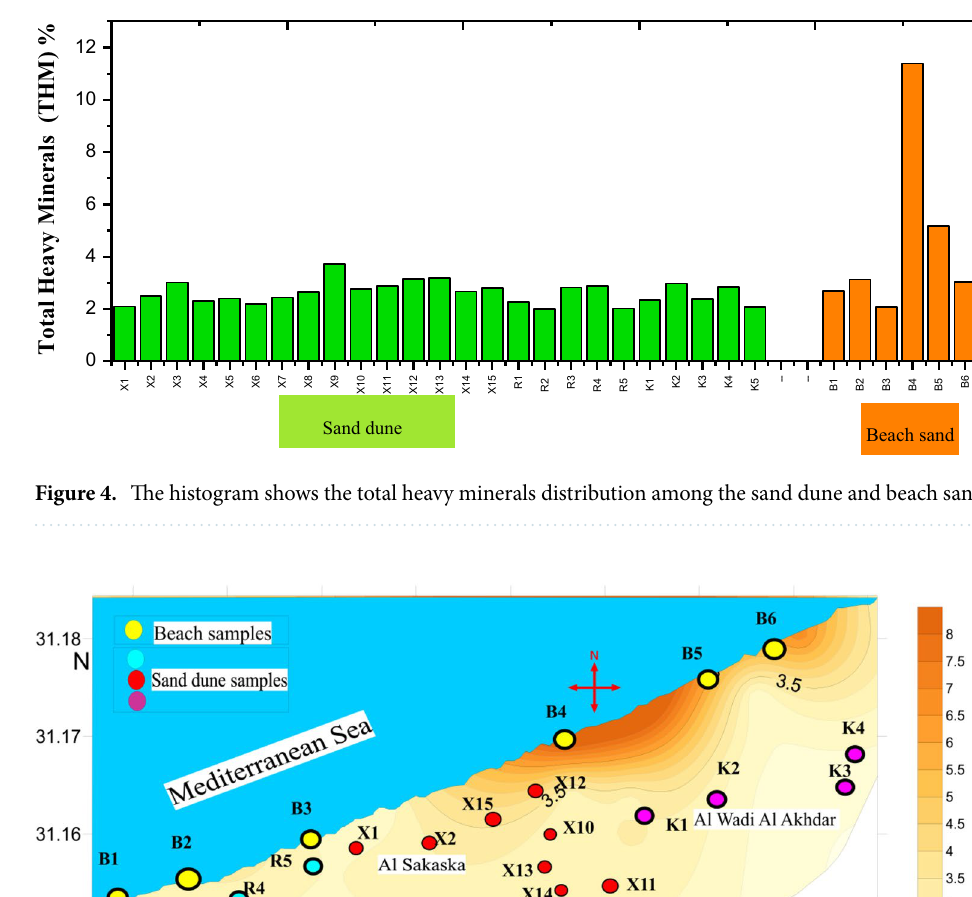
clear color with a vitreous luster 37,38 . Saxena 39 has stated that water-clear zircon grains in all types of rocks are nonmagnetic. In ore concentration terms, the zircon content values vary from 0.095% to 0.387%, with a mean of 0.203%, in the coastal dune samples and from 0.072% to 1.238%, with a mean of 0.410%, in the beach sam- ples. The majority of zircon shows a significant heterogeneity concerning composition 40–42 , crystal color 43 , and morphology 44,45 . Most of the zircon is colorless. According to crystal morphology, the studied zircon consists of colorless, short-to-long prismatic habits with bipyramid terminations (water clear zircon) (Fig. S4a), colorless prismatics with black inclusions (Fig. S4b), colourless oval shapes (Fig. S4c), and colourless rounded shapes (Fig. S4d). Magnetic zircon was recorded as yellow prismatics (Fig. S4e) with muddy (Fig. S4f.), orange (Fig. S4g), red, and black euhedral grains (Fig. S4h and i). The variation in the color of zircon may be attributed to the density of the fine inclusions and the degree of iron oxide staining. Some inclusions may be due to iron ions that penetrated from the original melt through the zircon lattice during magmatic crystallization or from an outside source 38 . These inclusions are considered weak points that accelerate grain disintegration. 39 . Fig. S5 illustrates EDX microanalysis and BSE imaging of zircon crystals as follows: a) typical euhedral zircon crystals indicating a short transportation distance, b) bipyramid zircon grains, c and d) fractured prismatic zircon grains indicating uranium loss, e) irregular zircon fragments, and f) bipyramid grains. Table 5 shows that Th oxide content varies from nil to 3.96 with a mean of 2.04, while U oxide content ranges between nil and 2.50% with an average of 0.74%. Hence, this is lower than the U and Th content in thorite and monazite. The elements Zr and Hf are frequently used in sediment source discrimination 46–48 . The Zr/Hf ratio ranges 11 to 21 lower than the chondritic value of ~ 30. Furthermore, the Zr/Hf ratio generally decreases from ultramafic